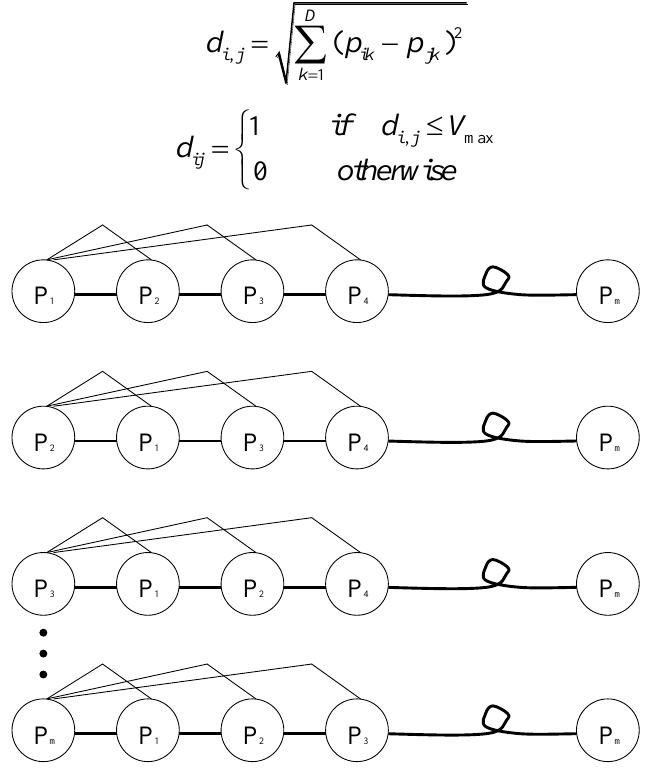
Figure 3. Schematic drawing to show distances with different